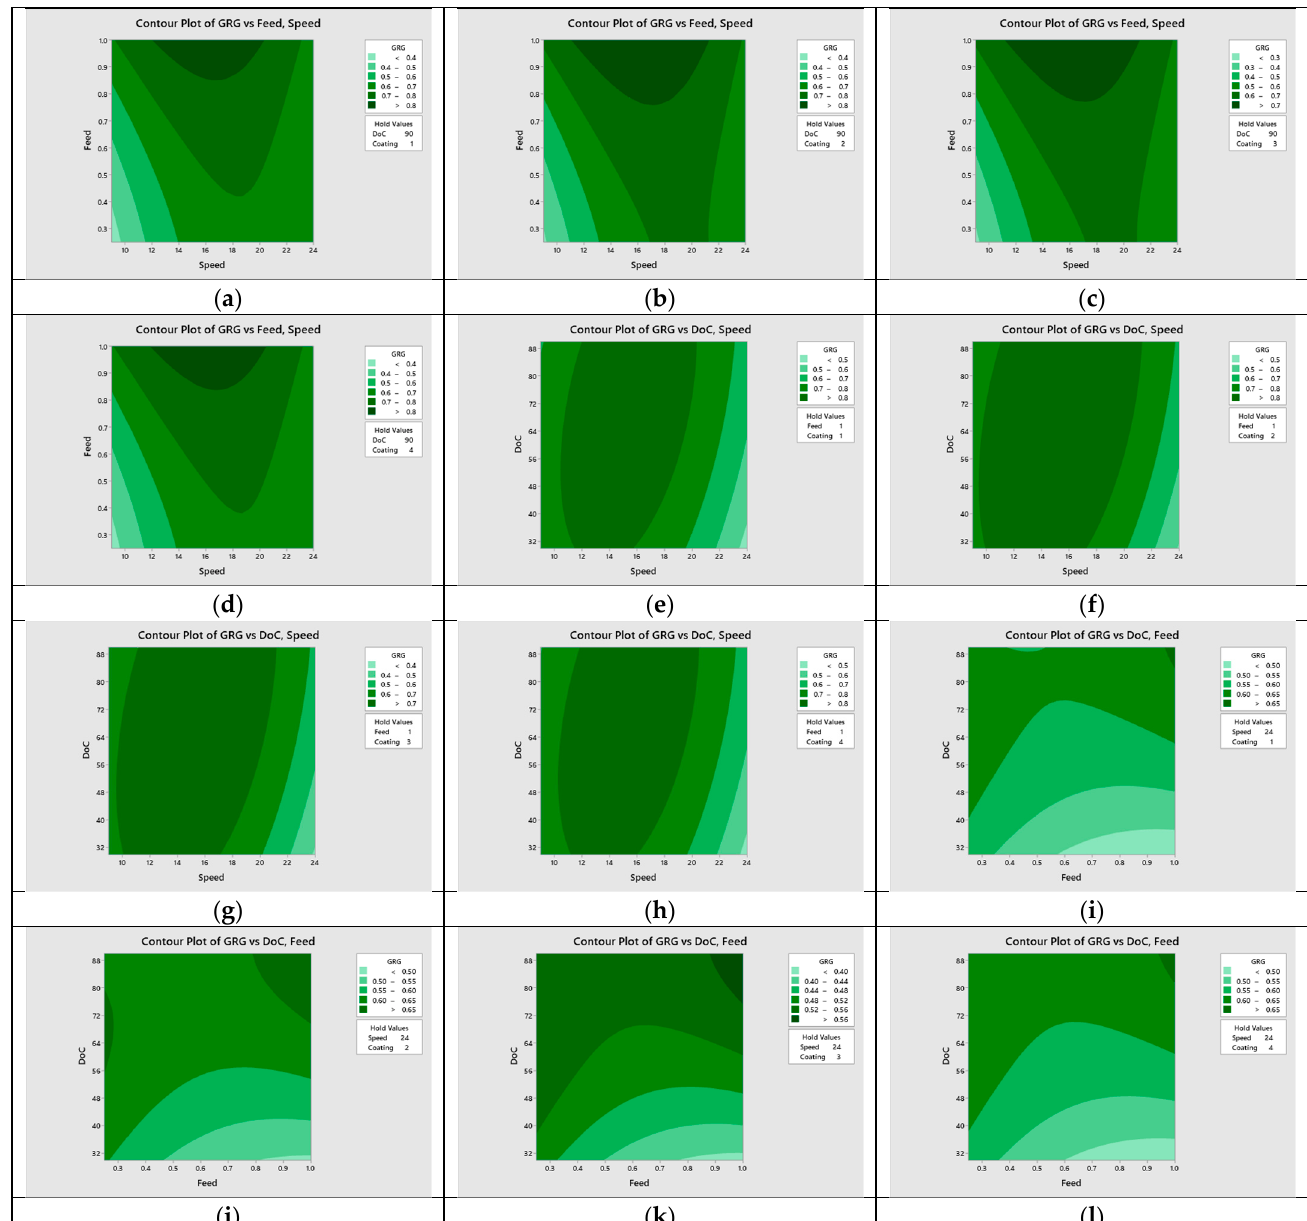
Figure 7. Contour plots of GRG vs machining parameters ( a ) speed vs feed, nACo; ( b ) speed vs feed, AlTiN; ( c ) speed vs feed, TiSiN; ( d ) speed vs feed, uncoated; ( e ) speed vs depth of cut, nACo; ( f ) speed vs depth of cut, AlTiN; ( g ) speed vs depth of cut, TiSiN; ( h ) speed vs depth of cut, uncoated; ( i ) feed vs depth of cut, nACo; ( j ) feed vs depth of cut, AlTiN; ( k ) feed vs depth of cut, TiSiN; ( l ) feed vs depth of cut, uncoated.